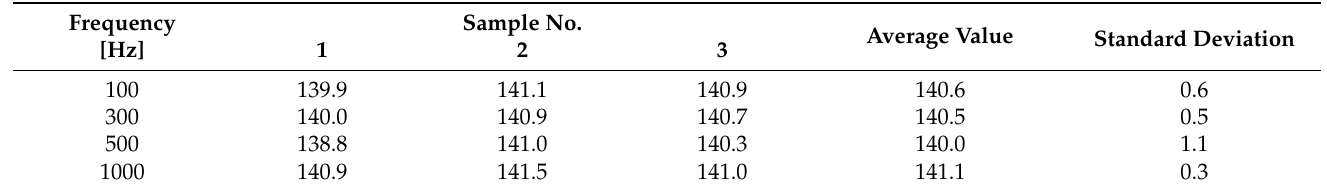
Table 8. Dynamic stiffness (dB re. 1 N/m) for PSMA5 poroelastic layer with SMA11 as binder course—laboratory measurements (L).